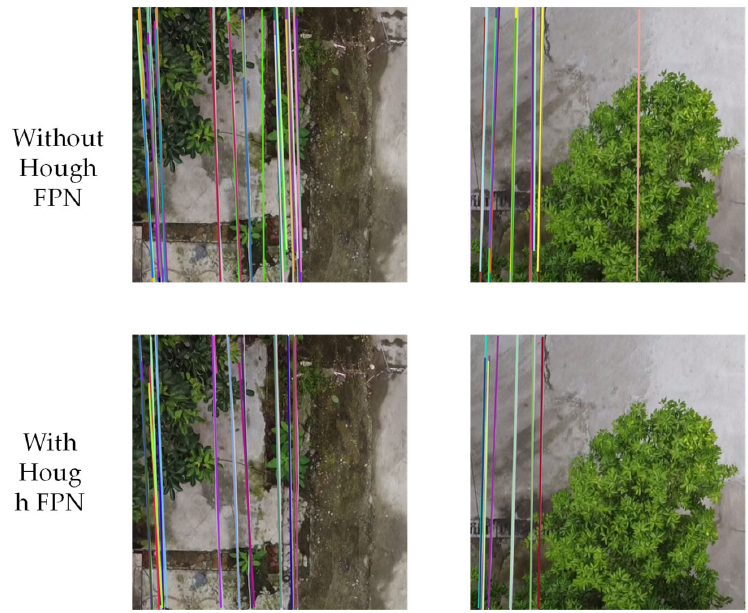
Figure 11. Comparison of performance in complex background performed using the models with or without Hough FPN.